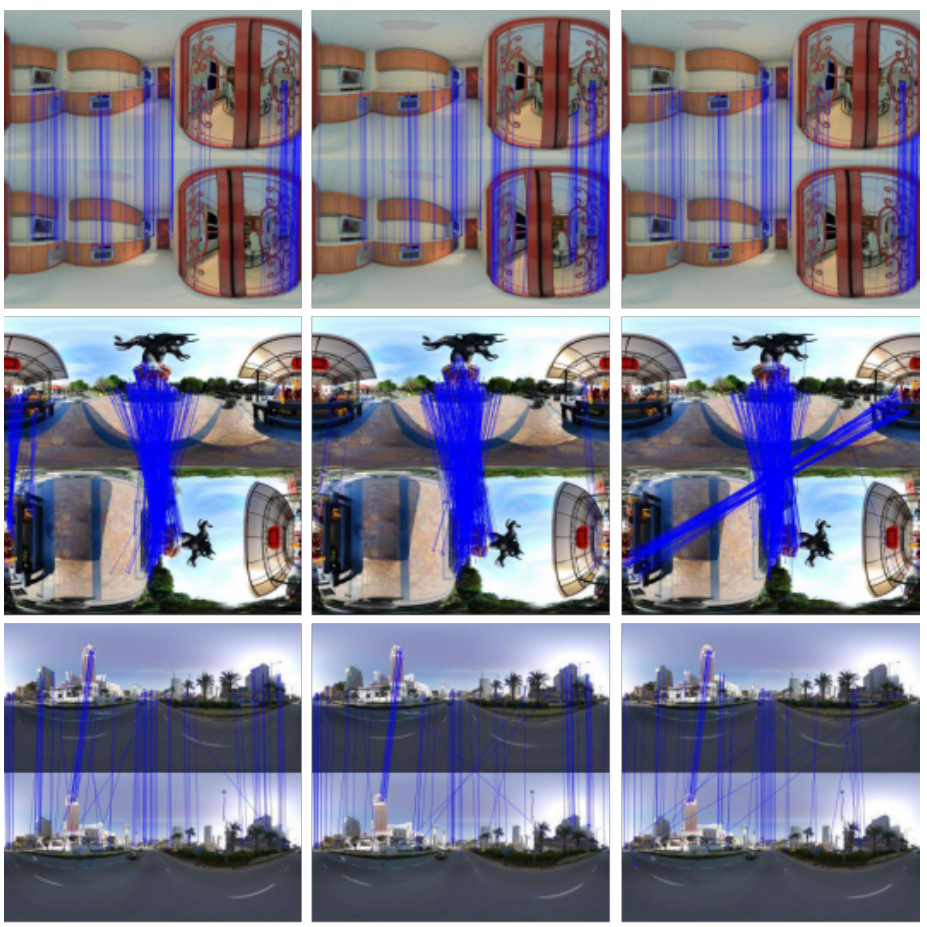
Figure 8. ( left ) sift; ( middle ) binary scale-invariant feature transform (SIFT); ( right ) ternary SIFT. The evaluation of matching results for different kinds of SIFT are listed in Table